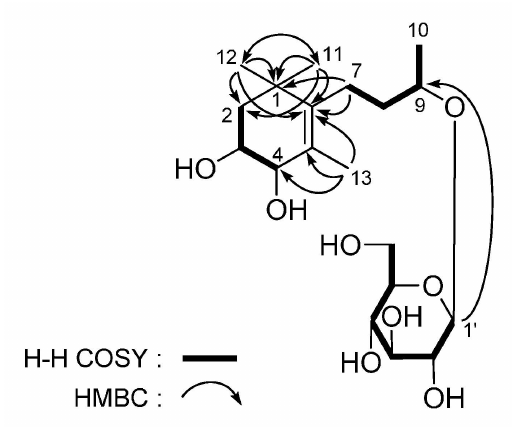
Figure 6. The main 1 H- 1 H COSY and HMBC correlations of 4